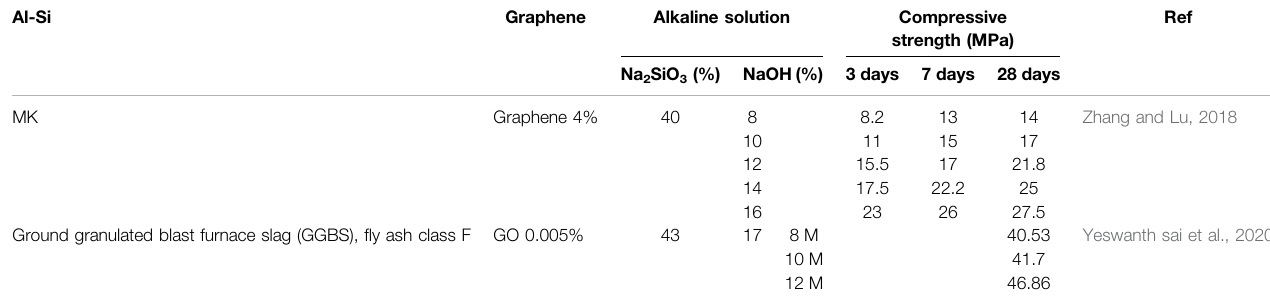
TABLE 2 | Compressive strength of Graphene Reinforced Geopolymer Nanocomposites at different alkaline solution concentration. Al-Si Graphene Alkaline